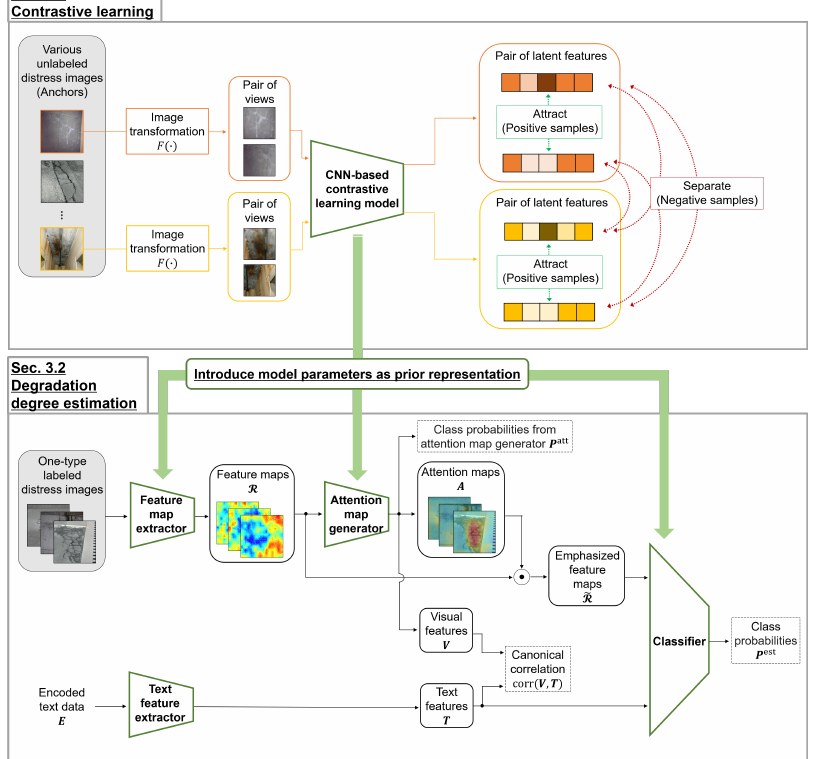
Figure 1. Overview of the proposed method in the training phase. Contrastive learning corresponds to Section 3.1 and is performed using CNN as the backbone. Augmented images, called views, are generated via image transformation F ( · ) from original images, called anchors. The latent space is constructed such that views from the same anchor are close to each other, and the others are separated from each other. Estimating degradation degrees of distress images corresponds to Section 3.2. The classification model is constructed based on ABN, which has the same CNN backbone of contrastive learning. As the initial parameters of the classification model, those obtained by contrastive learning are used. The parameters of contrastive learning are specifically set to the feature map extractor, attention map generator, and classifier in the model. In supervised learning for estimating the degradation degree, the classification model is trained using both images and their corresponding encoded text data E . The correct regions are emphasized in the attention map by using the canonical correlation calculated between the visual features V and text features T